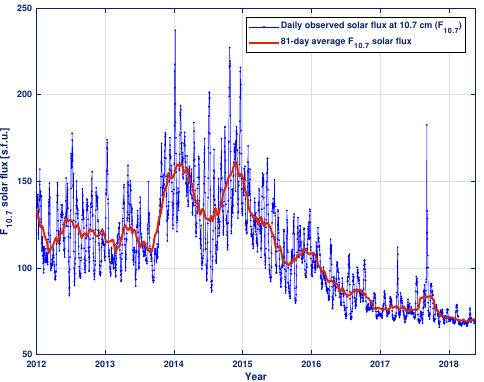
Figure 5. Solar activity since the launch of LARES. Daily observed solar flux at 10.7 cm and its 81-day values averaged over three solar rotations: from 1 January 2012 to 15 May